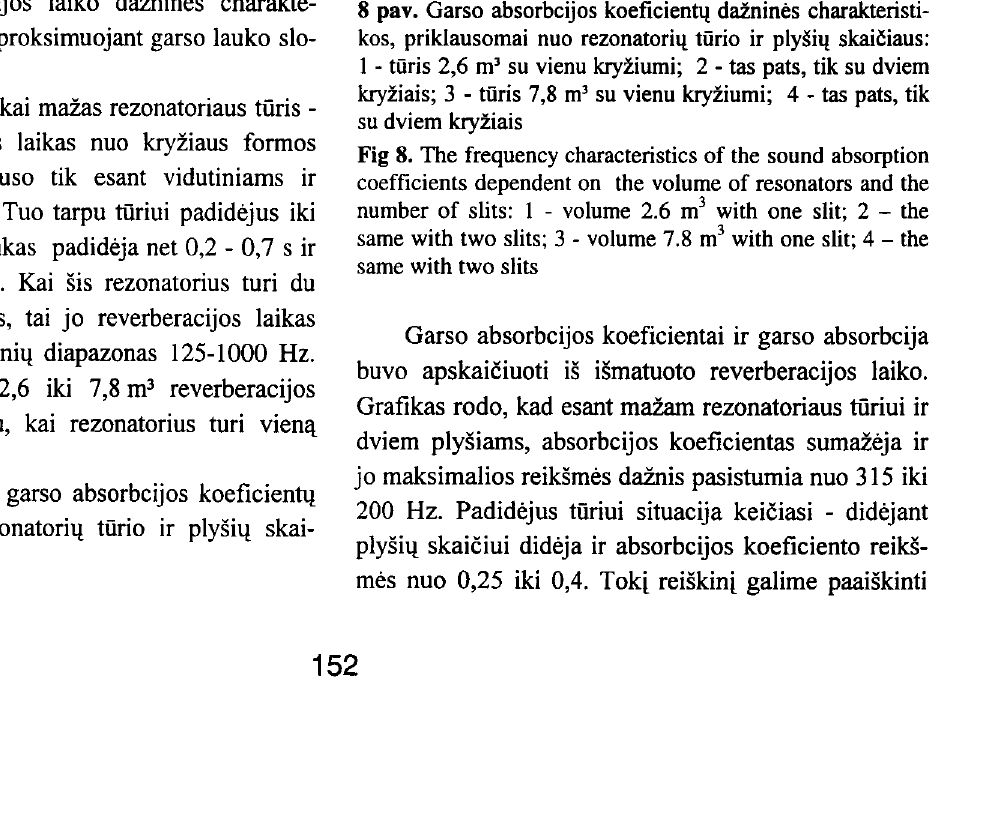
Fig 7. The frequency characteristics of the reverberation time dependent on the volume of resonators and the number of slits: I - volume 2.6 m 3 with one slit; 2 - the same with two slits; 3- volume 7.8 m 3 with one slit; 4- the same with